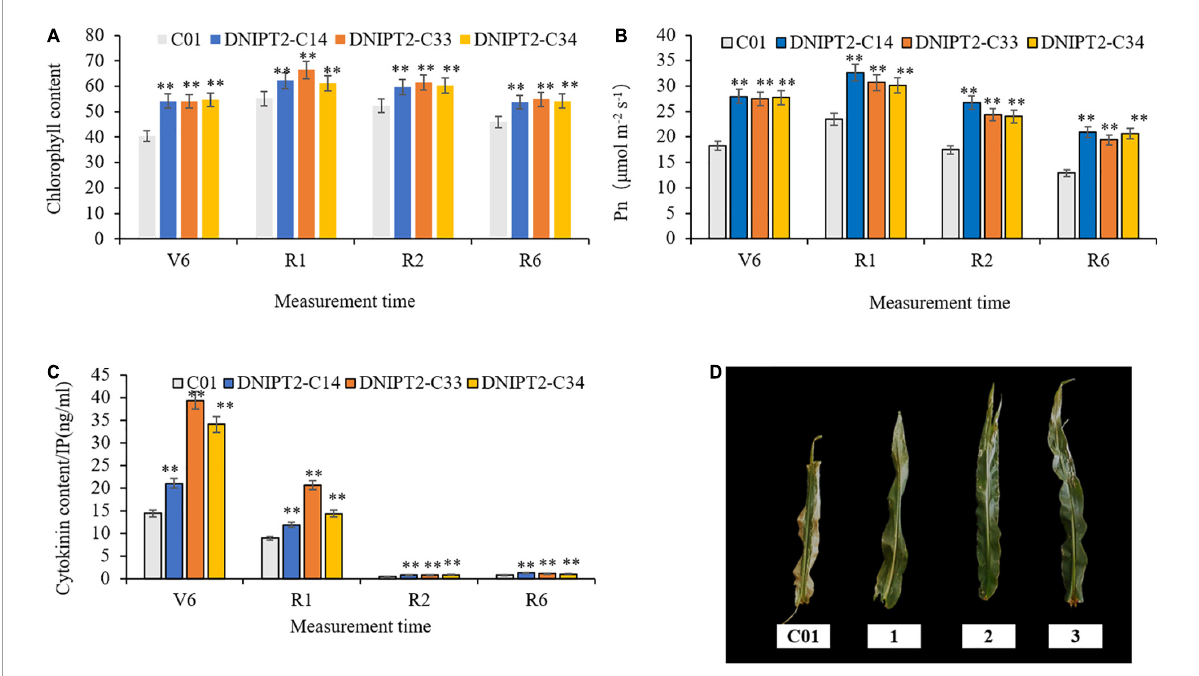
FIGURE3 Detection of physiological and biochemical indexes of transgenic maize lines with ZmIPT2 gene. (A) Shows the relative chlorophyll content of transgenic lines at different growth stages of maize, V6 (sixth leaf), R1 (silking), R2 (blister stage) and R6 (physical maturity); (B) shows the photosynthetic rate content of transgenic lines at different growth stages of maize, V6 (sixth leaf), R1 (silking), R2 (blister stage) and R6 (physical maturity); (C) shows the content of cytotaxon (CTK) of transgenic lines at different growth stages of maize, V6 (sixth leaf), R1 (silking), R2 (blister stage) and R6 (physical maturity). (D) The comparison of leaf greenness in T3 transgenic maize lines with ZmIPT2 gene at generation at mature stage, C01, negative control; 1, DNIPT2-C14; 2, DNIPT2-C33; 3, DNIPT2-C34. There was significant difference or extremely significant difference in the expression level of ZmIPT2 (** P < 0.01, Student t